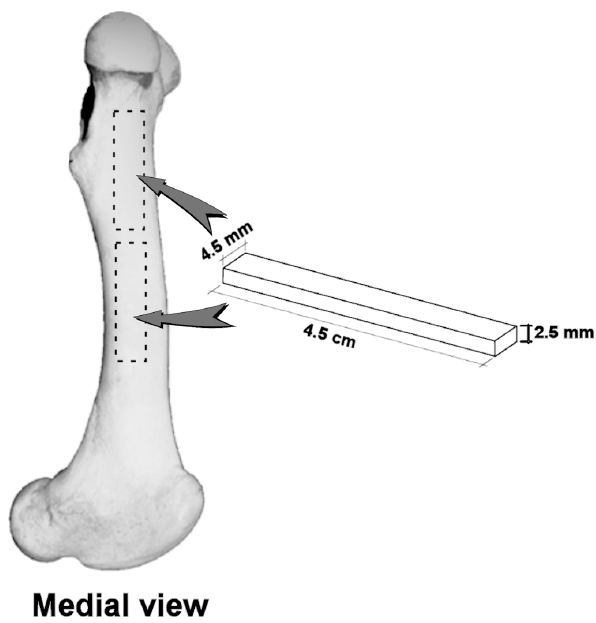
Figure 1. Sections of the femur sampled for chemical analysis (arrows) and mechanical testing (femur bars 45 mm 6 2.5 mm 6 4.5 mm indicated in the drawing).